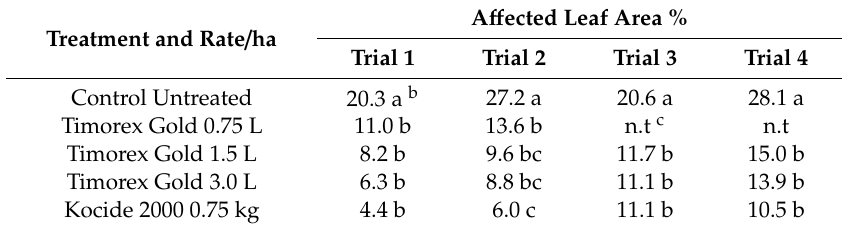
Table 3. E ffi cacy of formulated TTO in controlling downy mildew in field-grown lettuce plants a .